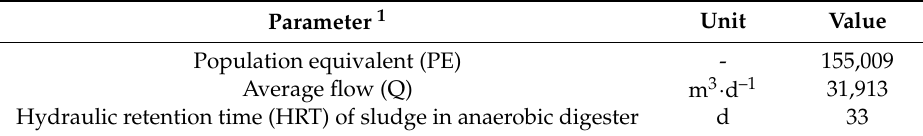
Table 1. The operational parameters of the Wastewater Treatment Plant.